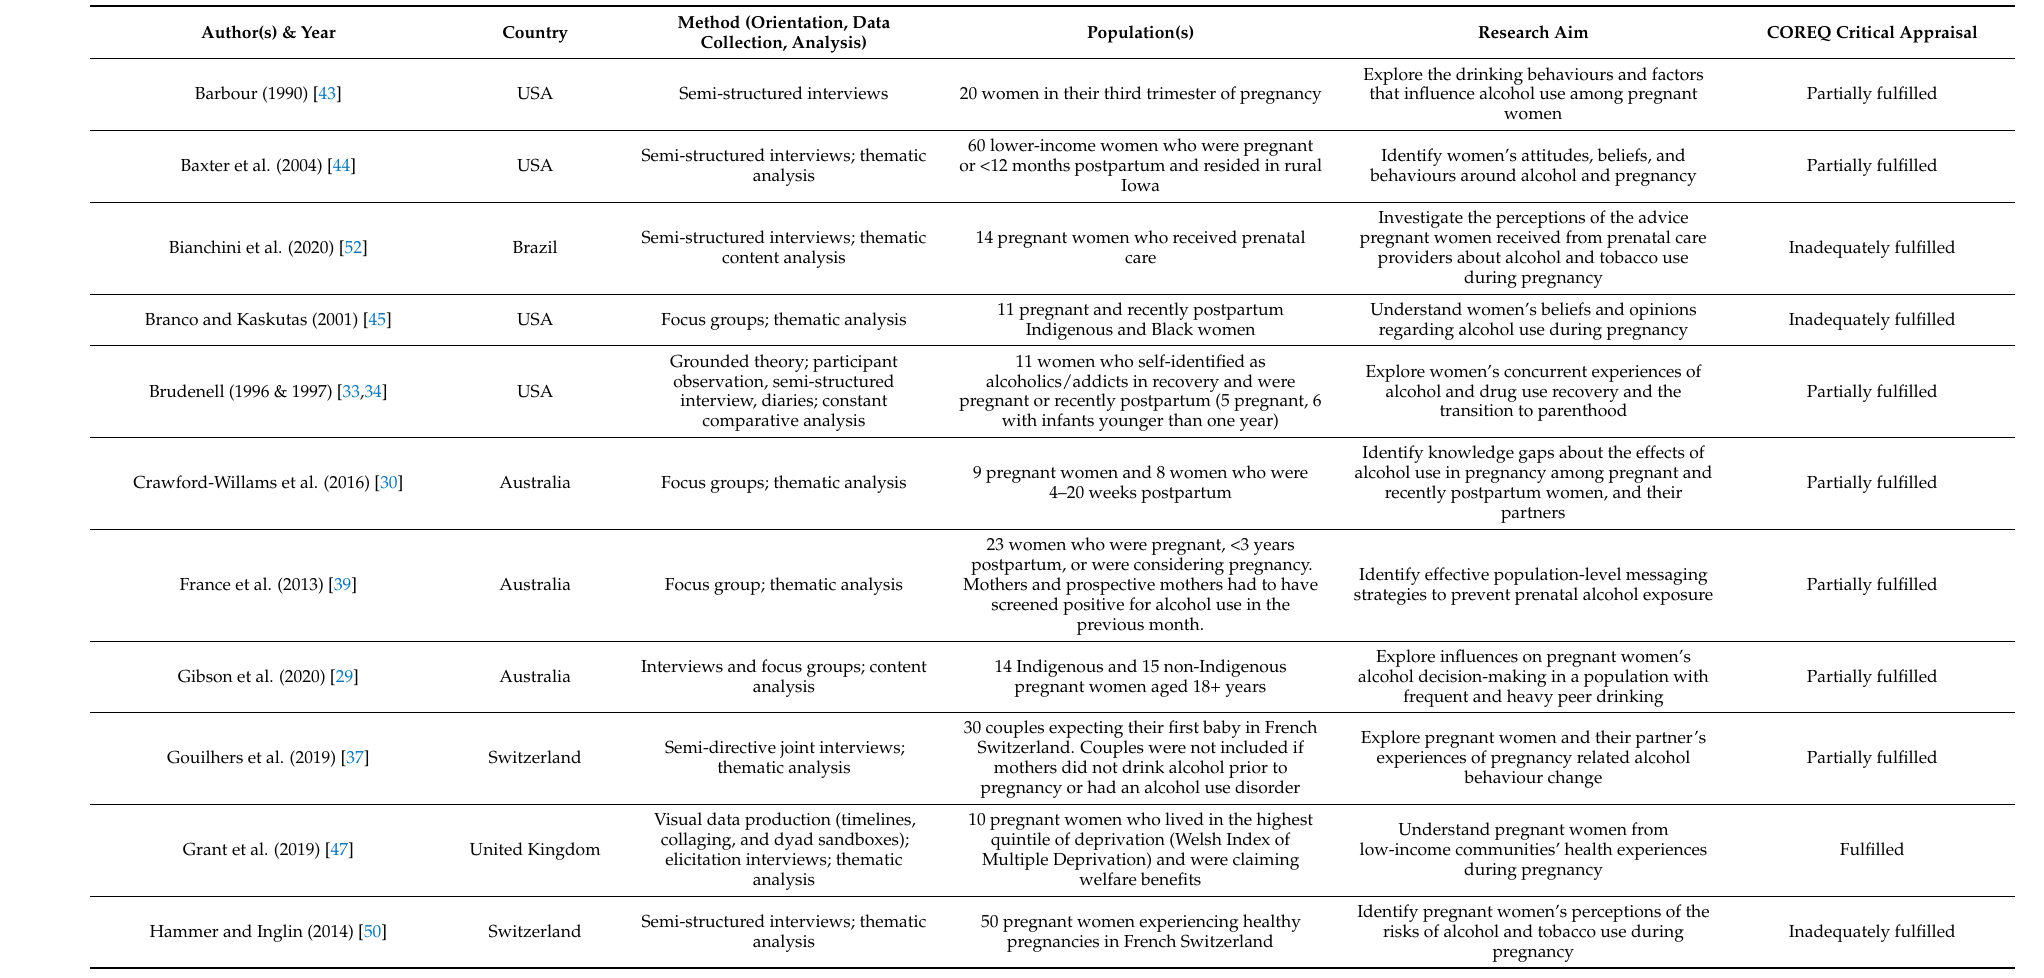
Table 2. Table of